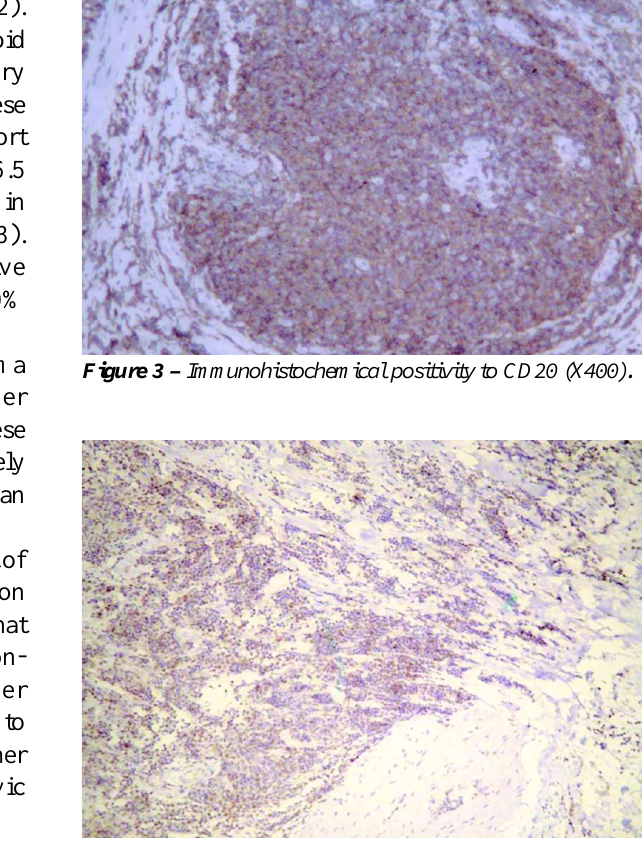
Figure 4 – Immunohistochemical positivity to bcL-2 protein, characterizing follicular lymphoma